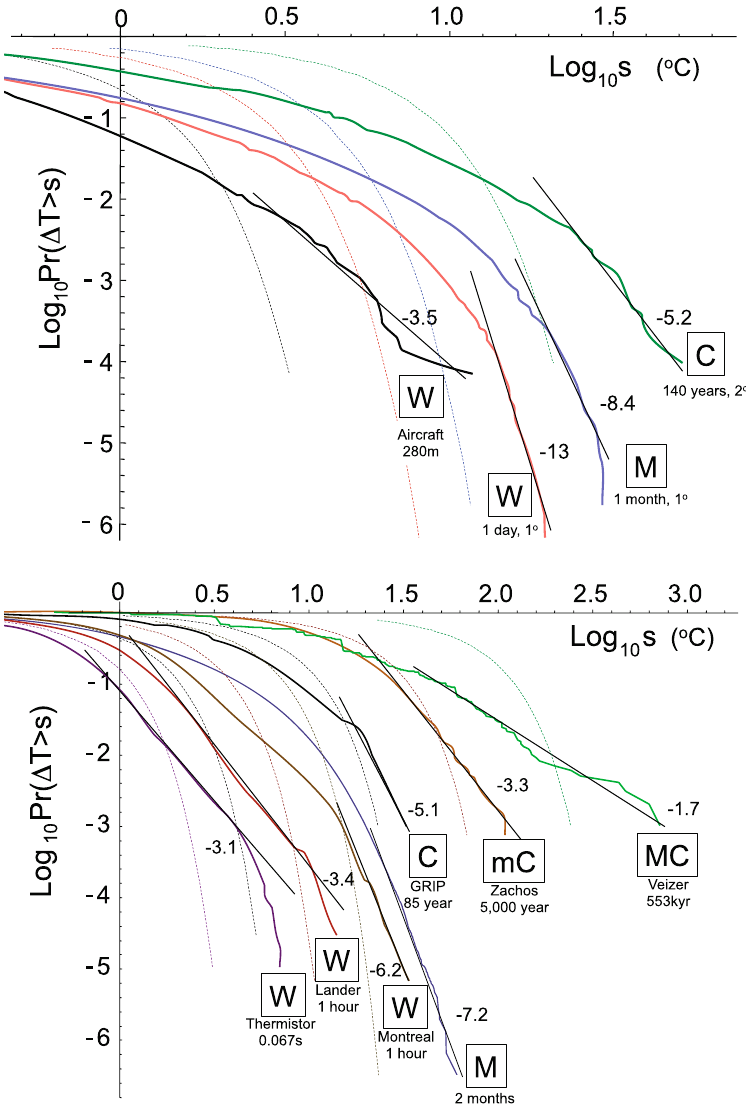
Figure 5. (a) (top panel): The probability distribution for absolute changes in the time series of Fig. 2b are shown. For clarity, they have been shifted to the right by factors left to right, respectively: 10, 1, 2, 4, 8, 16, 32). As discussed in Methods, reference lines give estimates of − q D indicated in the figure and in Table 2. Also shown for reference (dashed curves) are the Gaussian distributions that give the same mean and standard deviations. (b) (bottom panel): The same as ( a ) but for the transects used in Fig. 2c. Note that there plausible arguments that numerical model outputs and reanalyses (the two middle curves) tend to be too smooth and to underestimate extremes; this might explain some of the larger q D values (for weather and